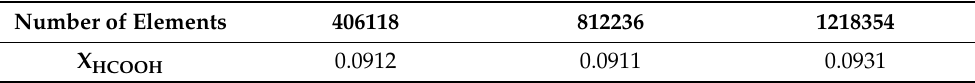
Table 1. Grid sensitivity analysis study for the packed bed microreactor used in this study. Reaction